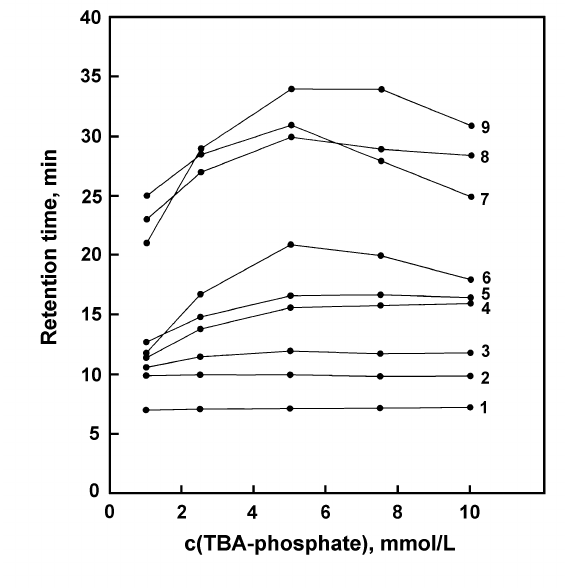
Fig. 1 Effect of TBA-phosphate concentration on retention times. Mobile phase: TBA- phosphate (pH 6.5), 20% (v/v) CH 3 CN; flow rate: 0.5 mL/min; UV detection at 210